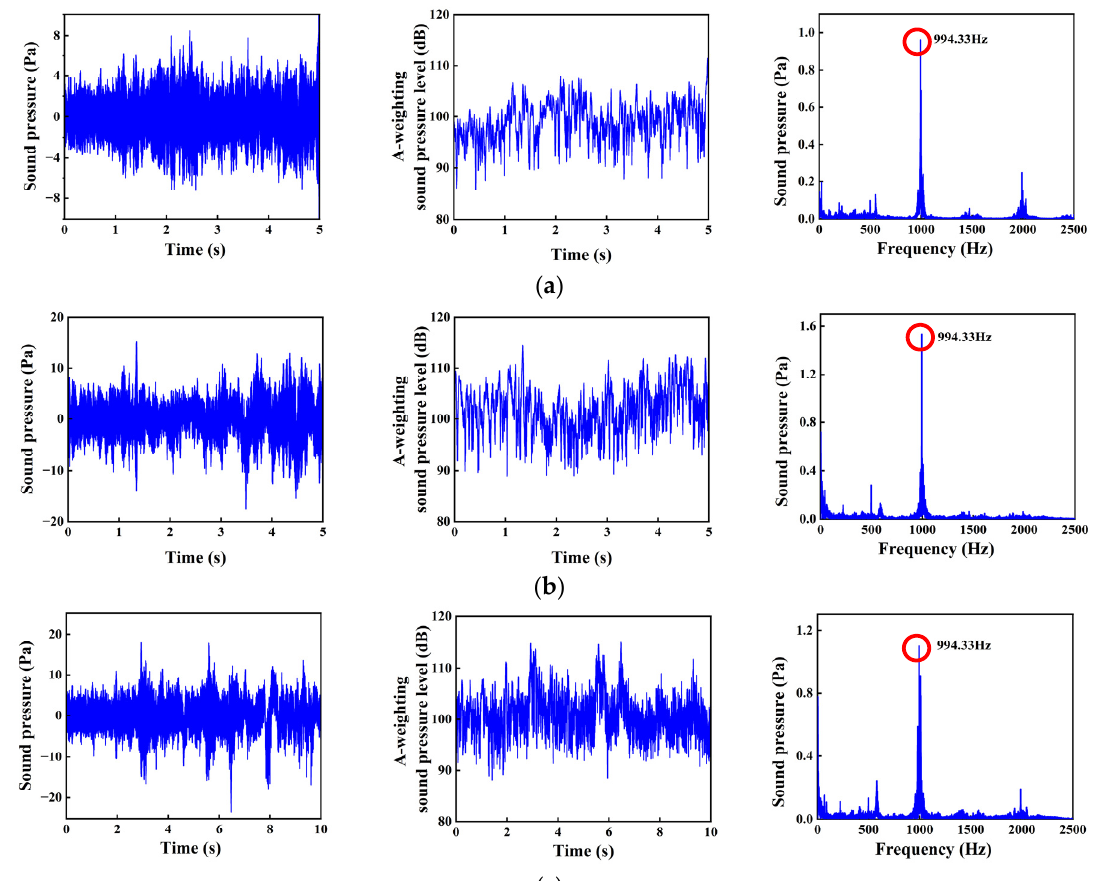
Figure 4. Sound pressure and A-weighting sound pressure level in time domain and frequency domain at three speeds (No. 9 traction motor): ( a ) 20 km/h, ( b ) 40 km/h, ( c ) 60 km/h.